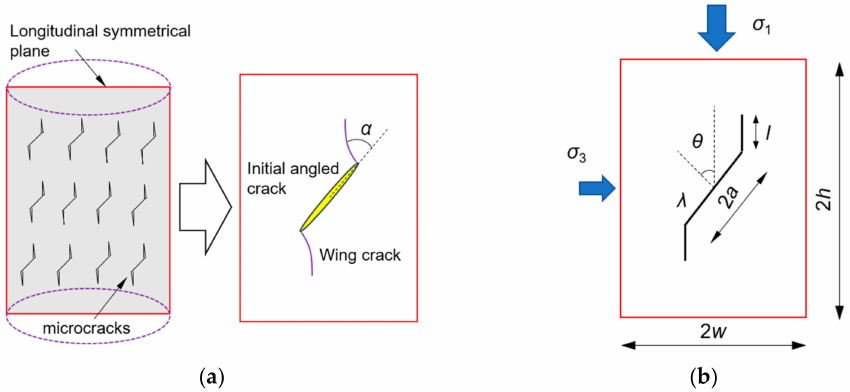
Figure 7. Rock model with crack structure: ( a ) superposition equivalence of microcracks; ( b ) sliding cracks with long wing crack